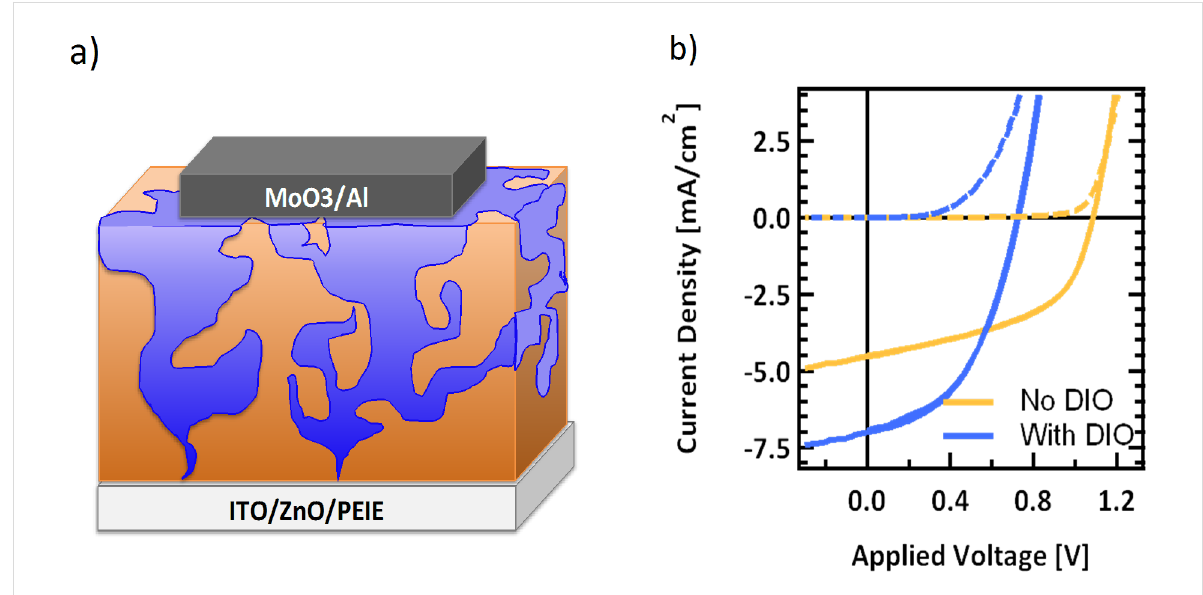
Figure 6: a) A schematic diagram of inverted architecture and b) J–V curves of device cast with no DIO in the standard (dashed) and inverted (solid) architecture.